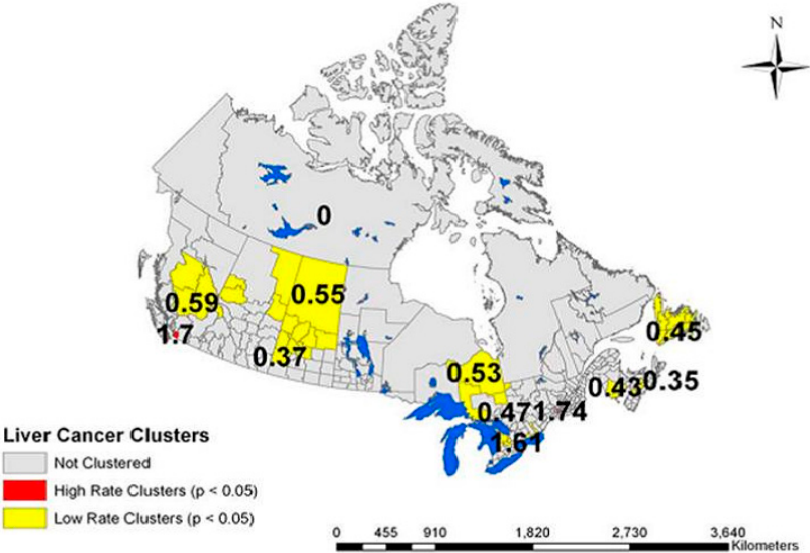
Figure 3. Cluster identification of liver cancer cases in Canada between 1996 and 2004, using spatial scan statistic (Satscan) software. The figure depicts regions of high and low rate clusters.